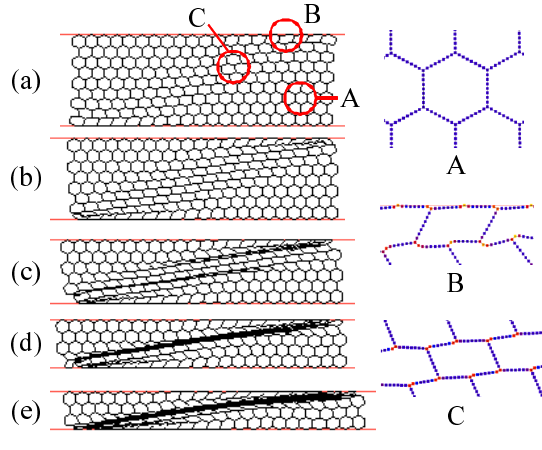
Figure 8. Deformation process of Type II